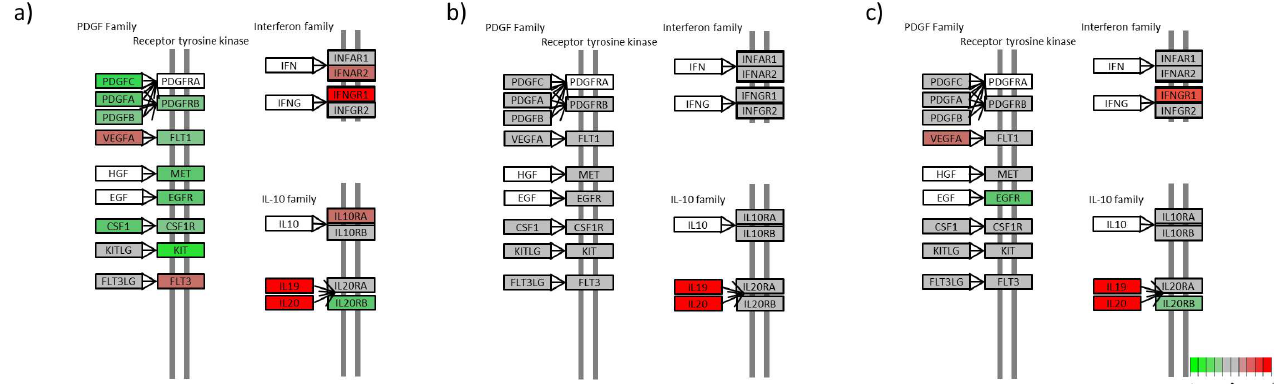
Fig 6. Cytokine-cytokine receptor interaction for the PDGF family, Interferon family and IL-10 family. (a) Untreated lesionalversus nonlesional, (b) Untreatedlesionalversus 4 days after adalimumab treatment was initiatedand (c) Untreated lesionalversus 14 days after adalimumab treatment was initiated. (Colours refer to the expressionlevel; green is downregulated, red is upregulatedin untreatedlesional psoriaticskin, grey is not regulatedand white is not includedin our data set) (Please find list of gene names in S4 Table).